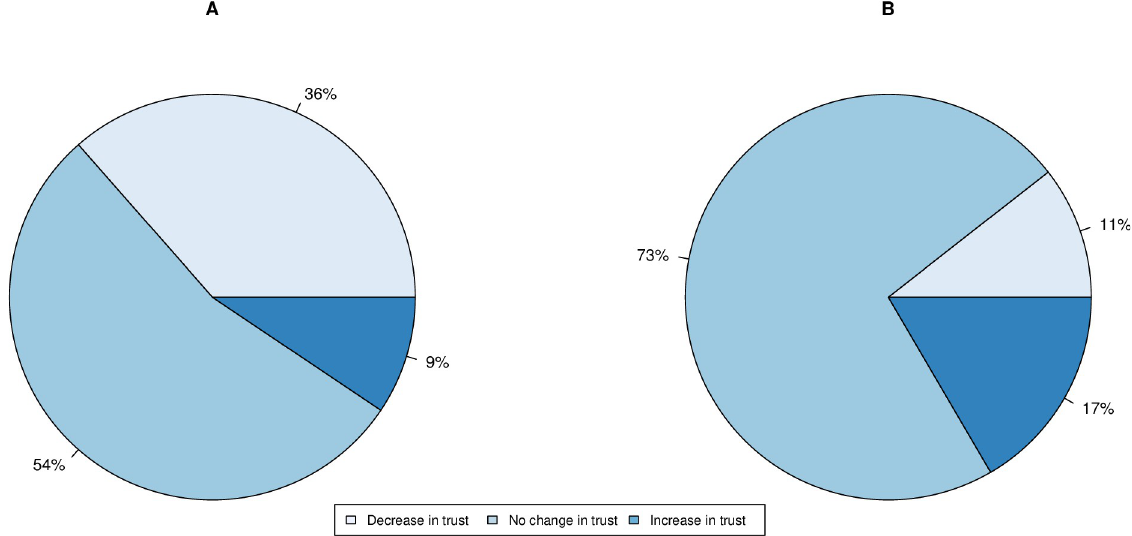
Fig 5. Proportion of individuals in each class of self-reported change in trust in scientists for A. those unwilling to be vaccinated (N = 85) and B. those willing to be vaccinated (N = 1930).